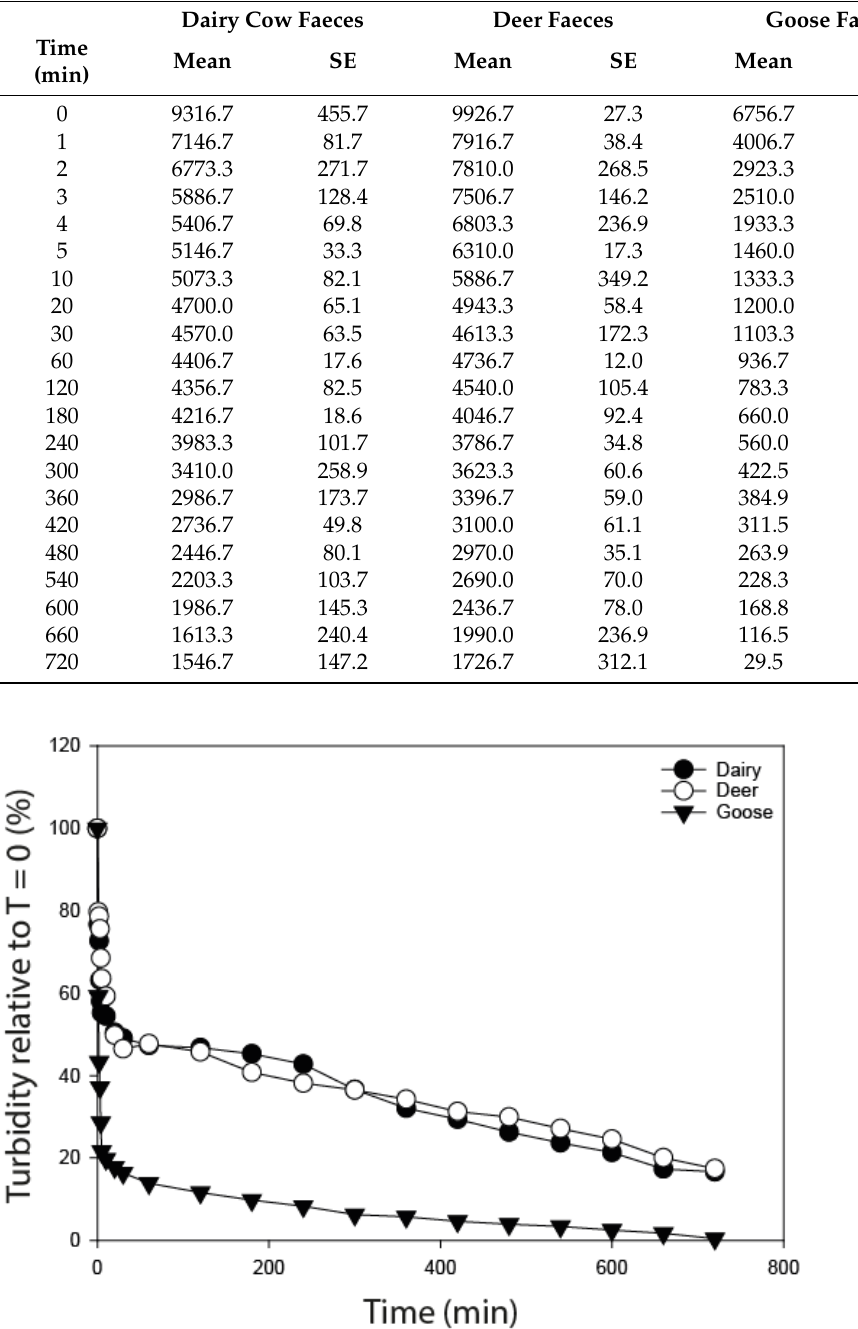
Table 2. Turbidity (Nephelometric Turbidity Units) values over time for each of the faecal treatments. Turbidity (Nephelometric Turbidity Units)